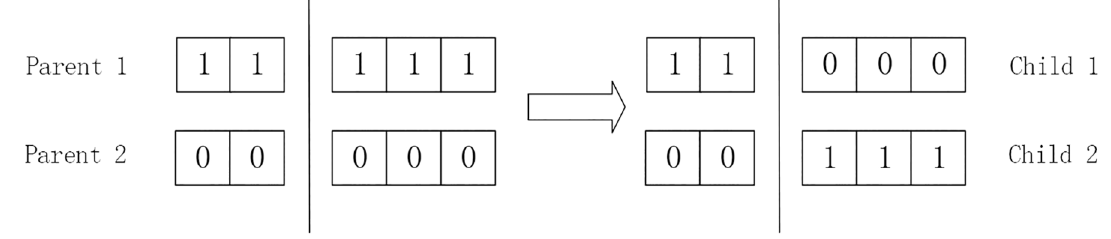
Fig 4. An example of crossover operator.